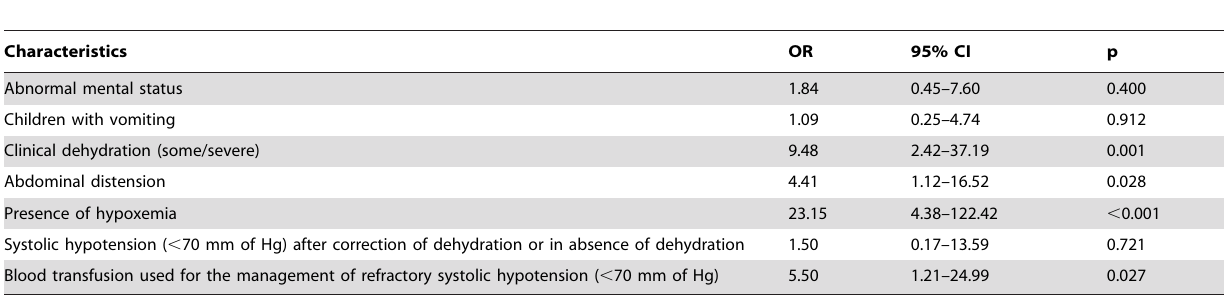
Table 2. Results of logistic regression to explore the independent risks of fatal outcome in under-five children with pneumonia and severe acute